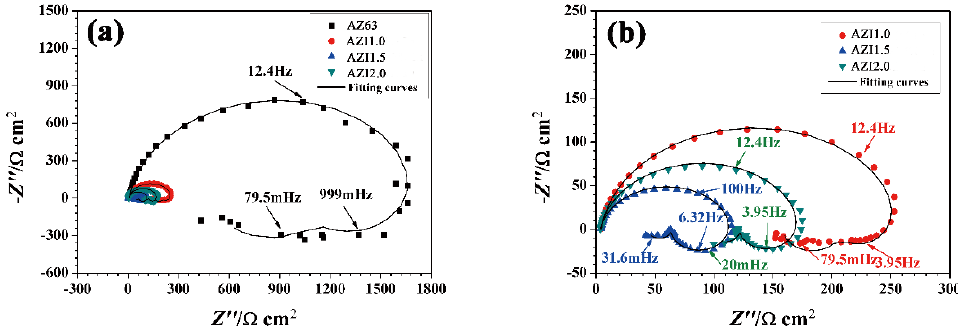
Figure 7. Nyquist plots and fitting curves of ( a ) AZ63 and AZI alloys and ( b ) details of vague section in ( a ) after 1 h immersion in 3.5 wt% NaCl at 25 ± 1 °C.